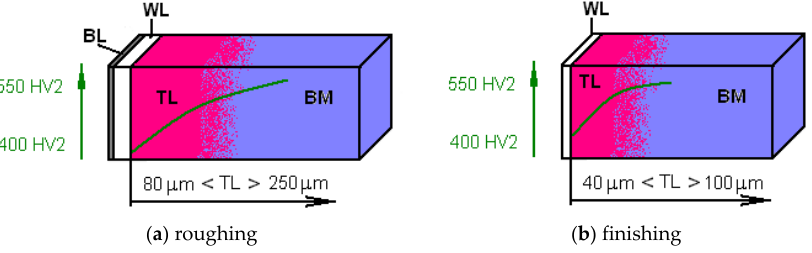
Figure 6. Total transition layer (TL) depth in HAZ of material EN X32CrMoV12 ‐ 28 after die ‐ sinking EDM roughing and finishing.